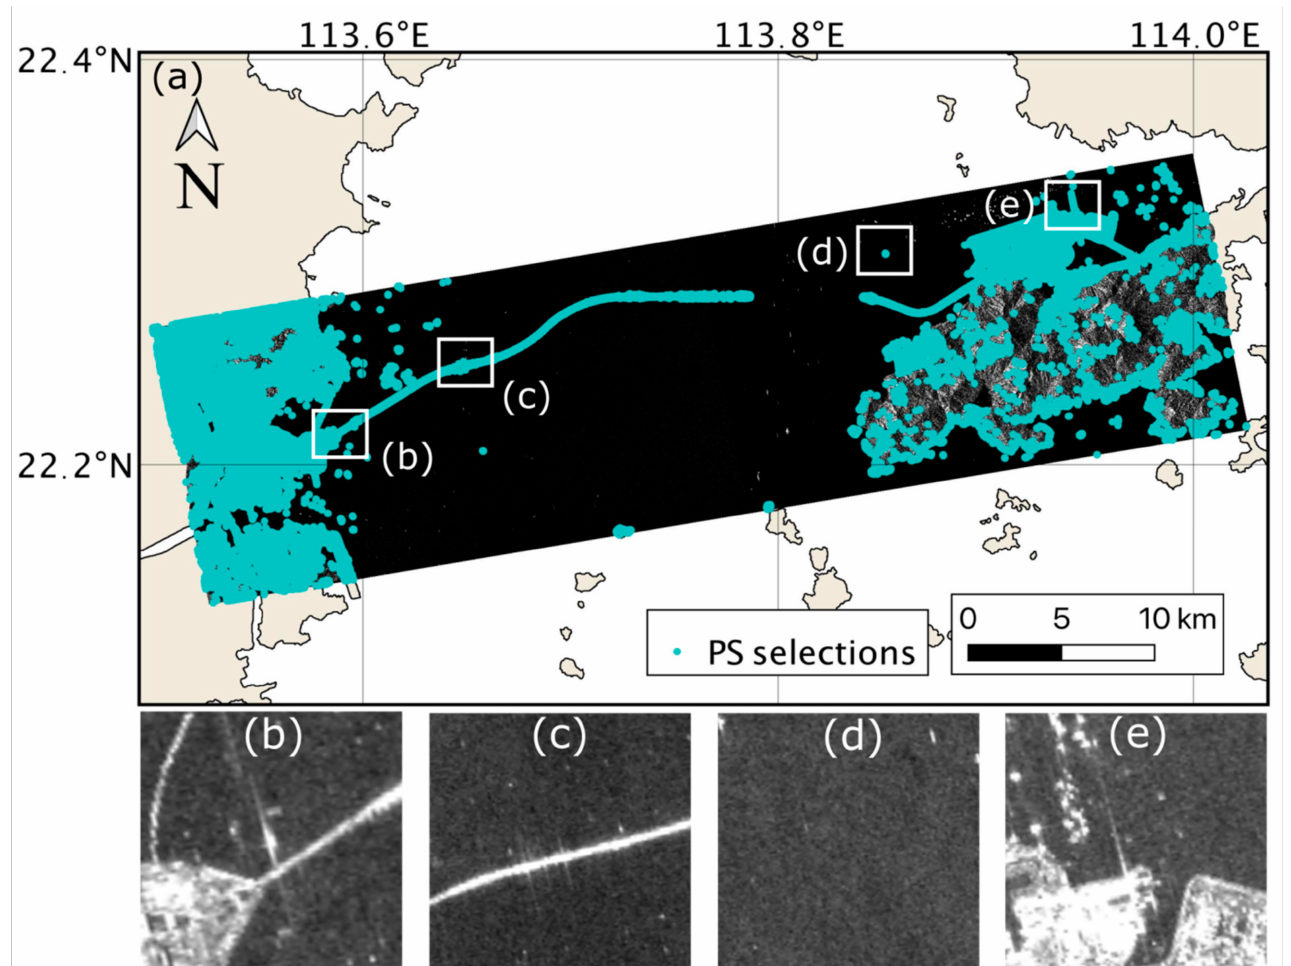
Figure 3. ( a ) PS selections denoted as blue points; ( b – e ) are subsets of the multiple look (10 × 2 looks) image on 10 October 2020, among which ( b ) is one permanent scatter that has occurred since acquisition on 6 May 2018, with long tails along the azimuth direction; ( c ) is one segment near the JHB showing strong permanent scatters; ( d ) is one example of false selection affected by speckle noise; ( e ) is one permanent scatter with a long tail. The tail along the azimuth direction shown in ( b , c , e ) is caused by a strong side lobe